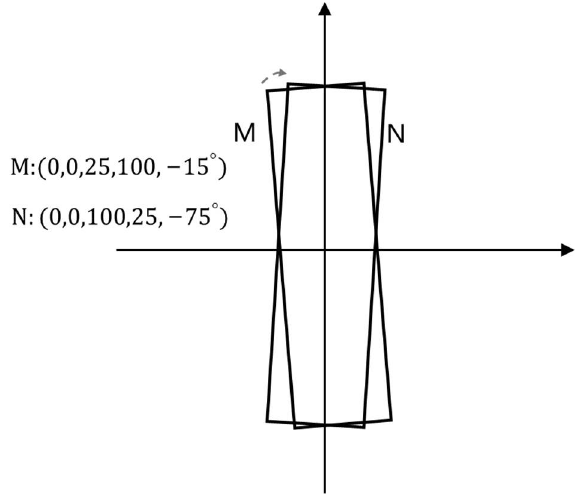
Figure 2. Auxiliary illustration of five-parameter method defects.